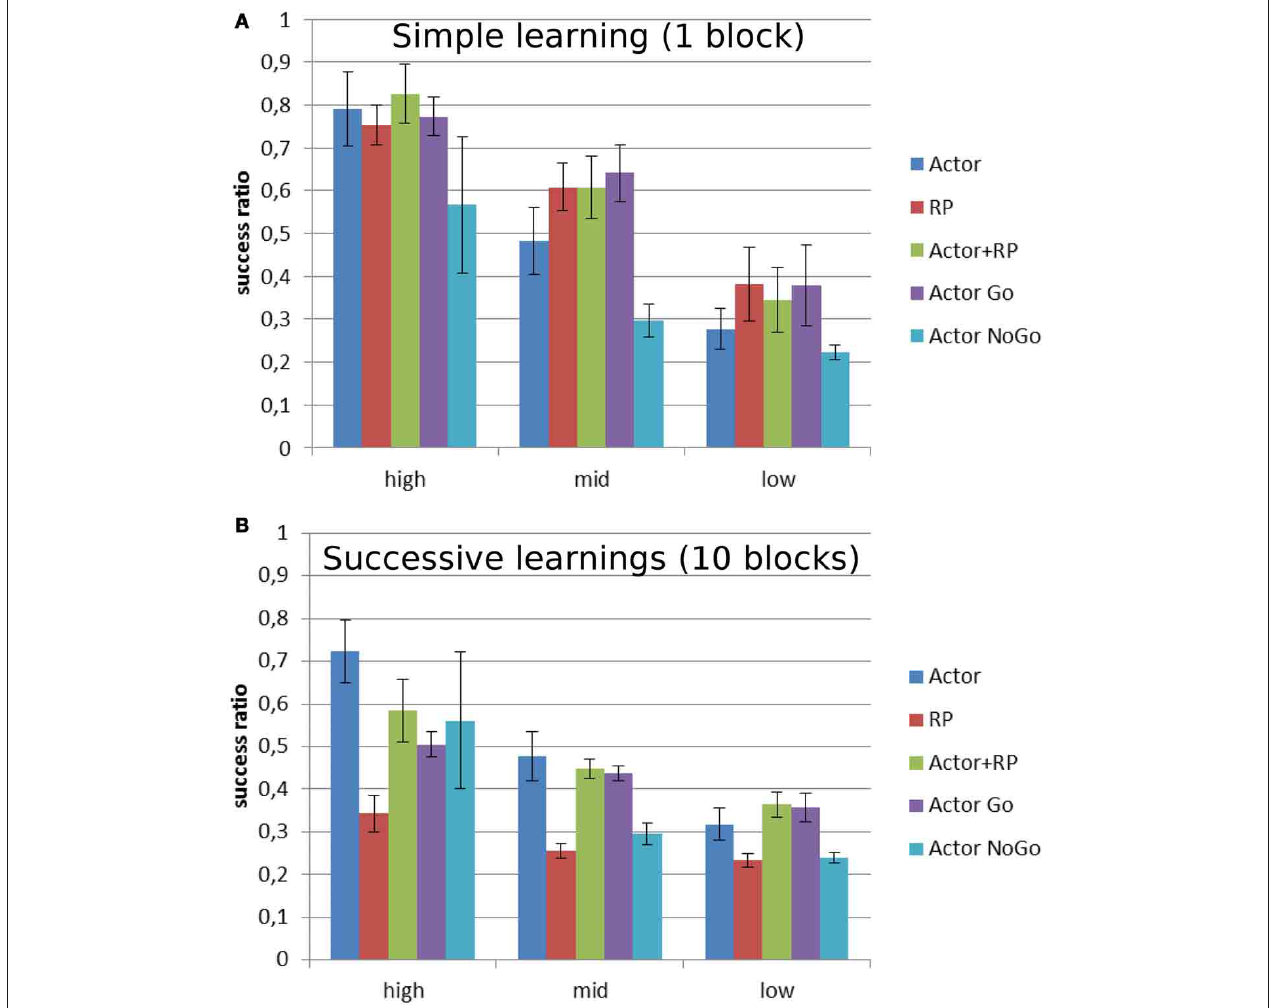
FIGURE 6 | Average success ratio of the different selection mechanisms on two versions of a stochastic reward task. Mean success ratio and standarddeviation(errorsbars)areshownforthreelevelsofrewardprobability: high = 100–80%, mid = 70–50%, and low = 40–10% (A) Stochastic simple